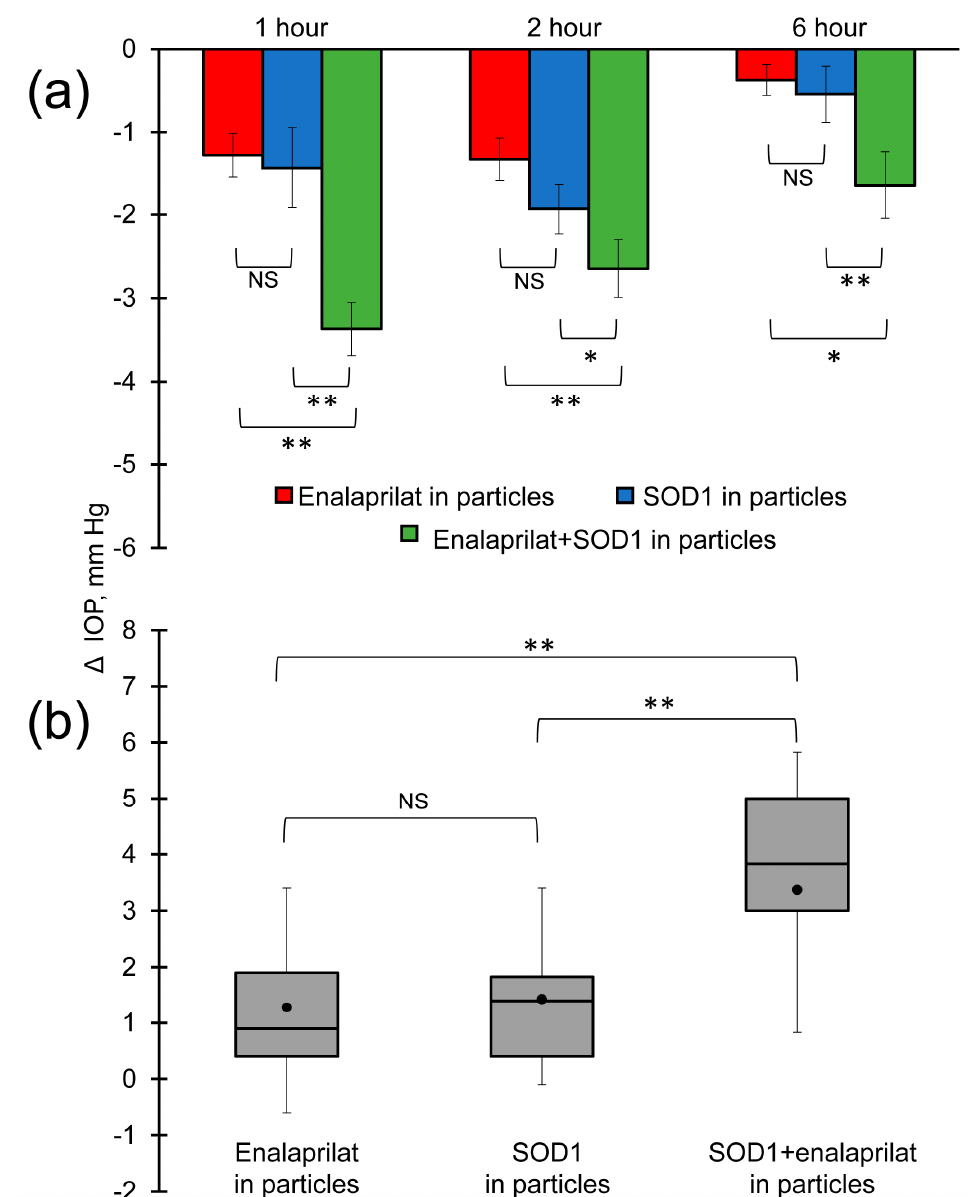
Figure 6. ( a ) IOP decrease in normotensive rabbits after single instillation of enalaprilat-loaded hybrid particles (red), SOD1-loaded hybrid particles (blue) and SOD1/enalaprilat co-loaded hybrid particles (green). ( b ) Comparison of IOP decrease in normotensive rabbits an hour after single instillation of enalaprilat-loaded hybrid particles, SOD1-loaded hybrid particles, and SOD1/enalaprilat co-loaded hybrid particles. The mean is marked with a dot. Value interval 25–75% is indicated by the grey area. * p < 0.05, ** p < 0.01.